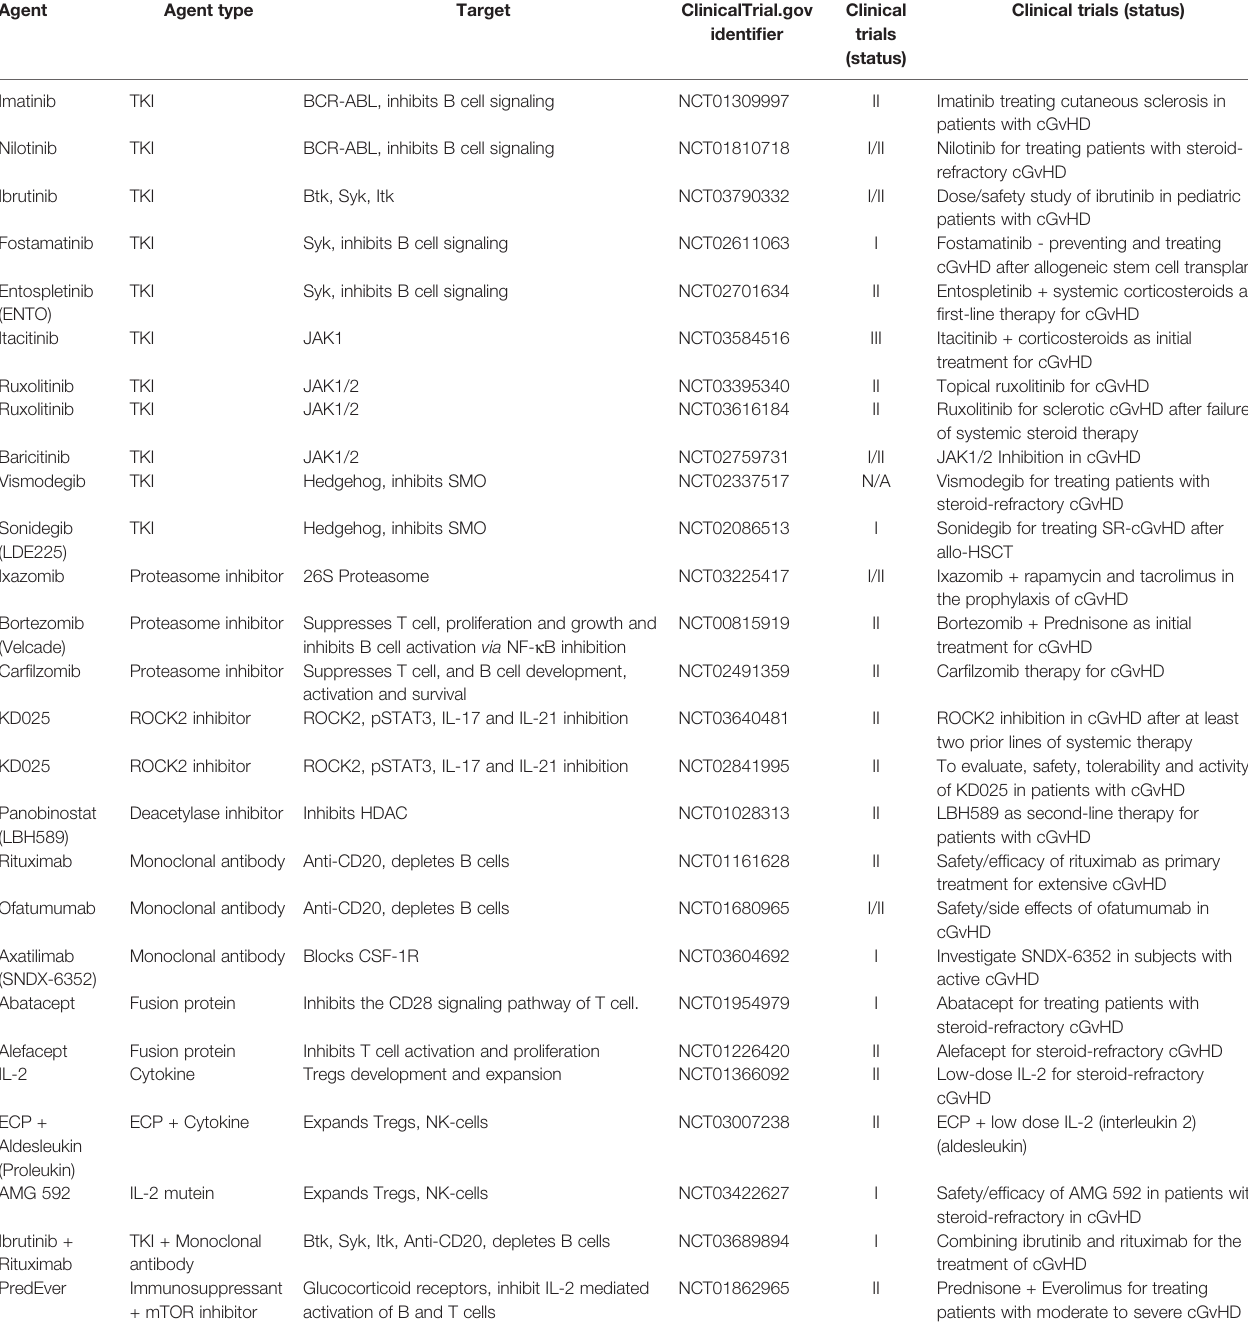
TABLE 2 | Selected ongoing studies evaluating novel drug agents in patients with cGvHD.